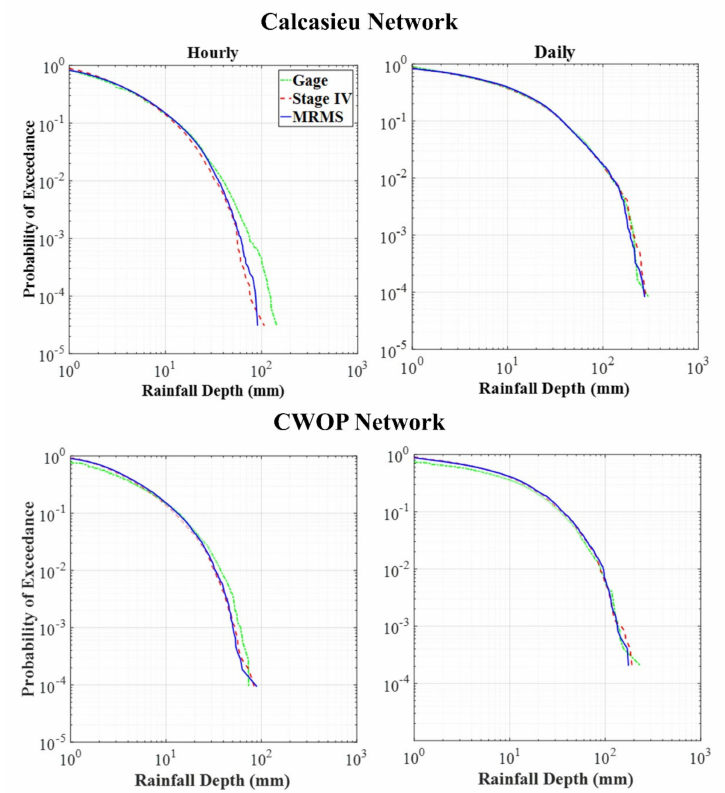
Figure 8. Comparison of probability of exceedance of rainfall intensities for the Stage IV and MRMS products against the surface rainfall networks. The comparison is performed for hourly (left column) and daily (right column)